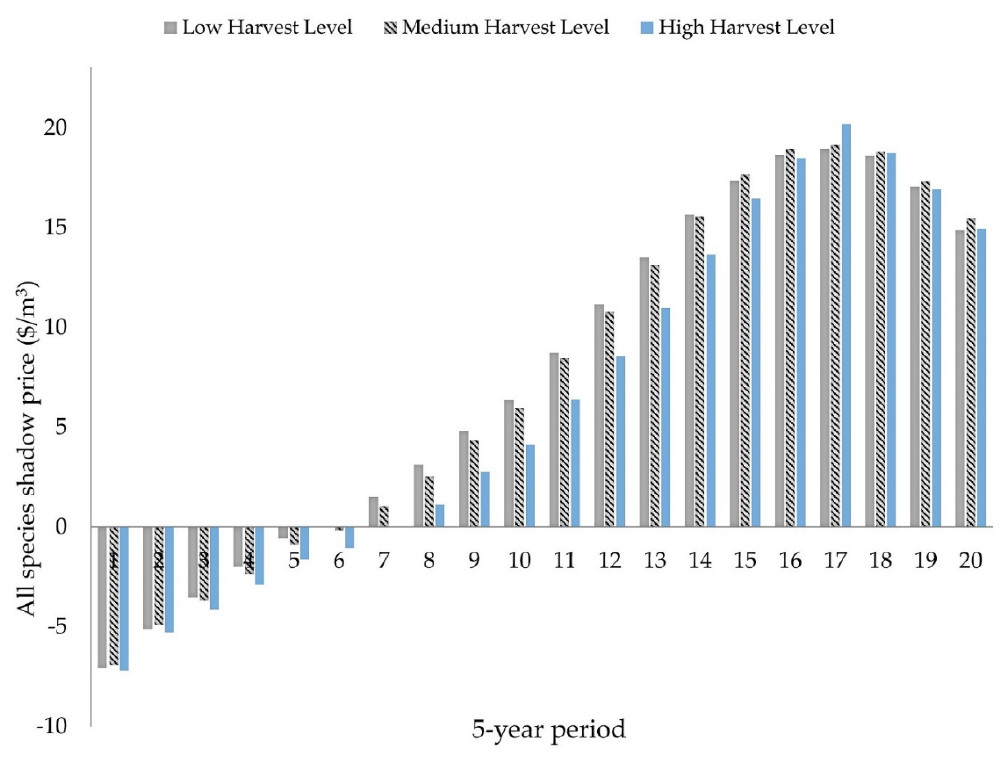
Figure 6. Shadow prices estimates for the all species volume constraints across all three aspen harvest levels (low, medium, and high).